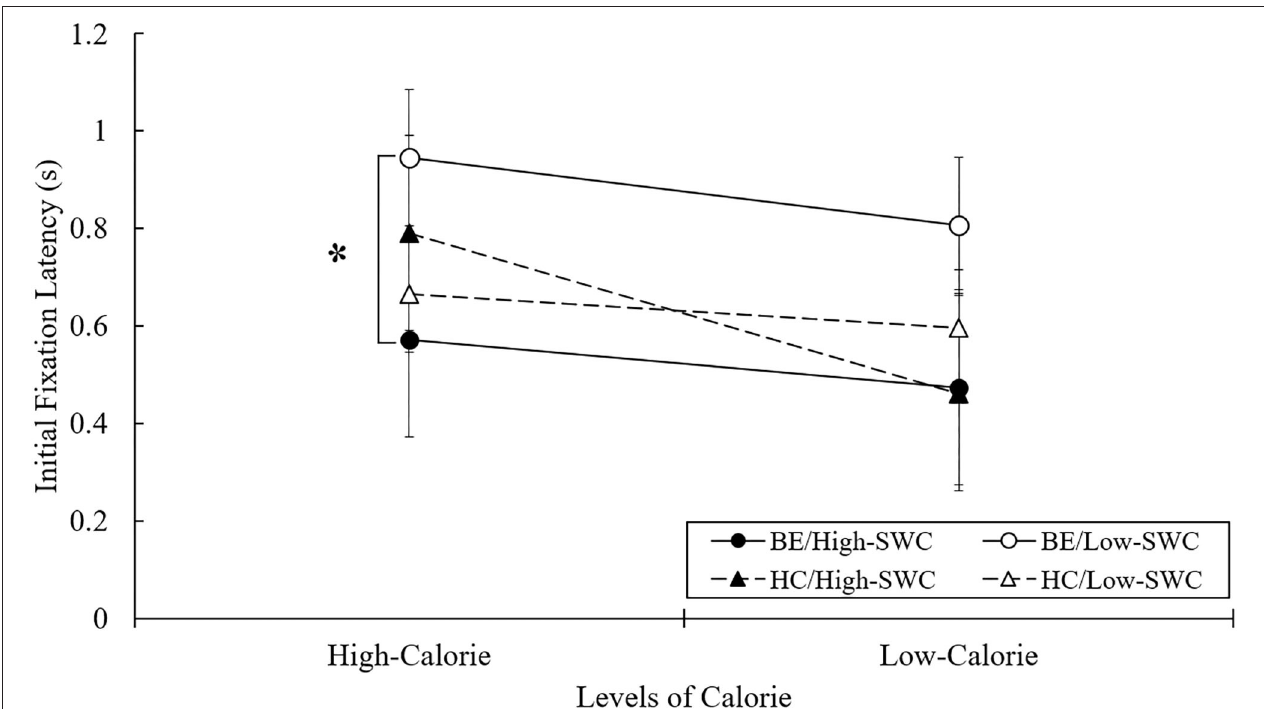
FIGURE 2 | Mean initial fixation latency in free-viewing task. BE, binge eaters; HC, healthy controls; SWC, shape/weight concern. * p < 0.05.